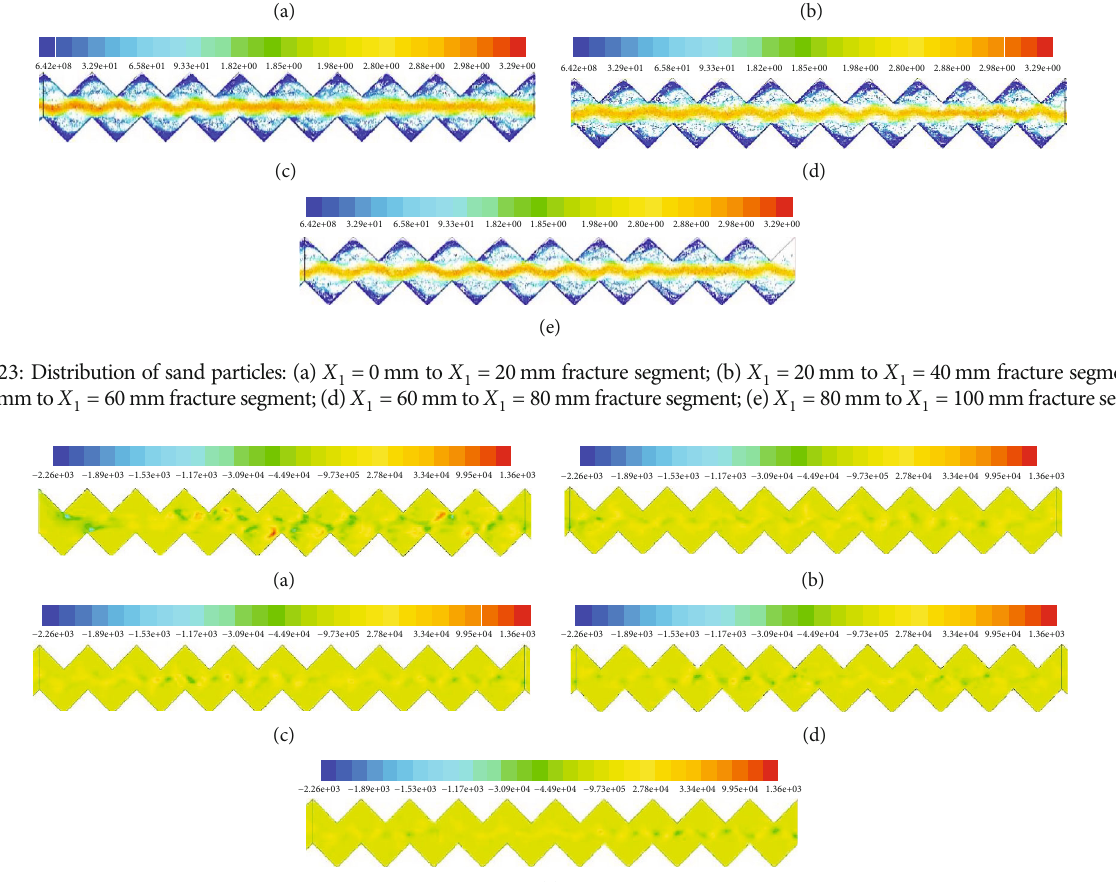
Figure 24: The momentum source term of the discrete-phase model in the X X = 20mm to X 1